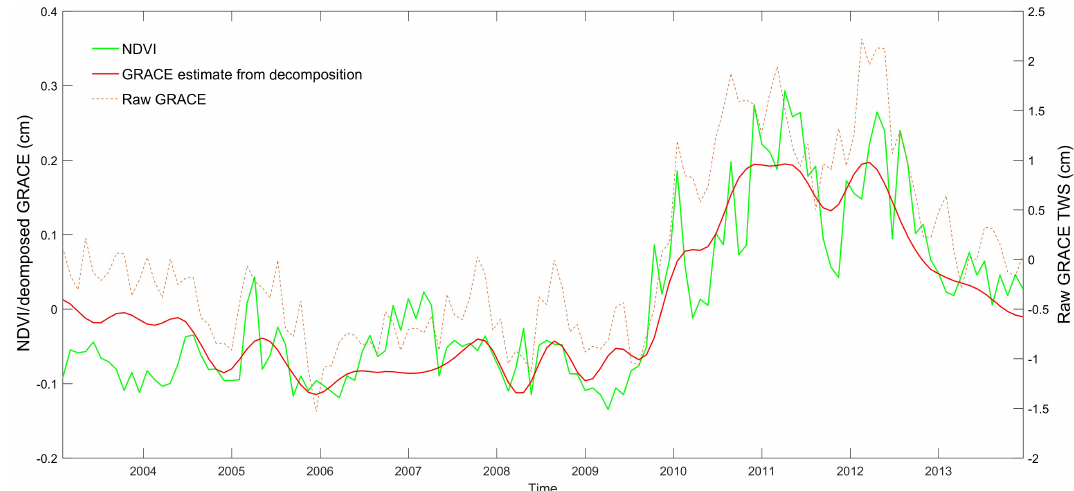
Figure 5. An example of the time series from a single cell. The new estimate uses the coefficients from A 4 0 , A 4 6 , and D 4 as selected by the stepwise regression. Pearson’s coefficient ( r ) between the decomposed GRACE estimate and NDVI ∗ is 0.872, compared with 0.665 when using raw GRACE TWS ∗